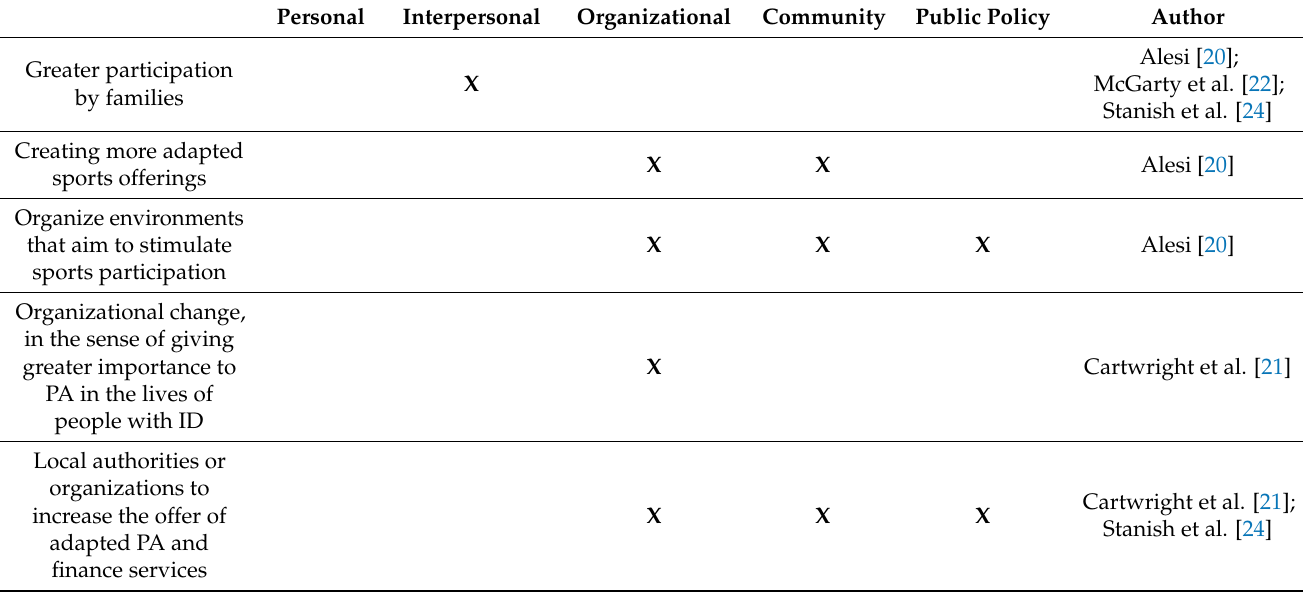
Table A1. Relationship between Ecological Model for Health Promotion and study